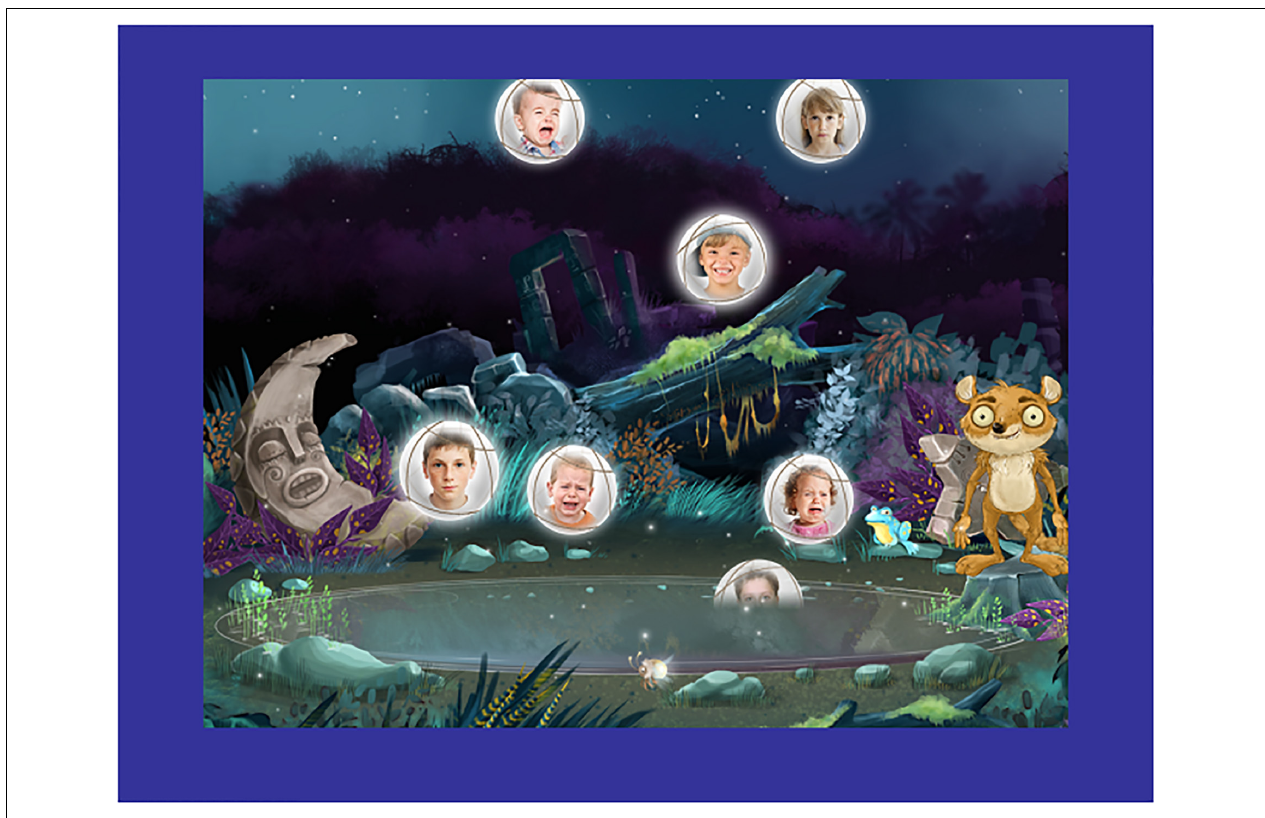
FIGURE 1 | A screen shot of the Pond Poppers